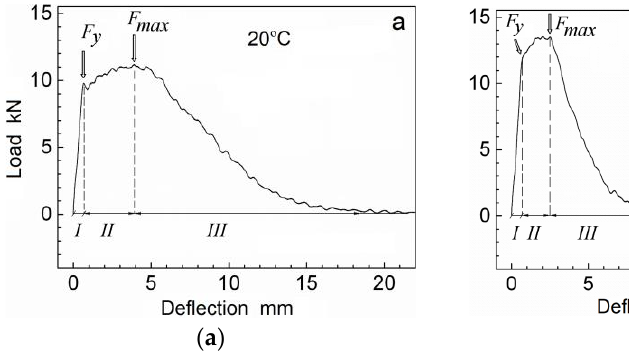
Figure 5. The fracture surfaces of the samples after the tensile tests at T = −30 °C ( a ), T = −80 °C( b ) and T = −196 °C ( c ).